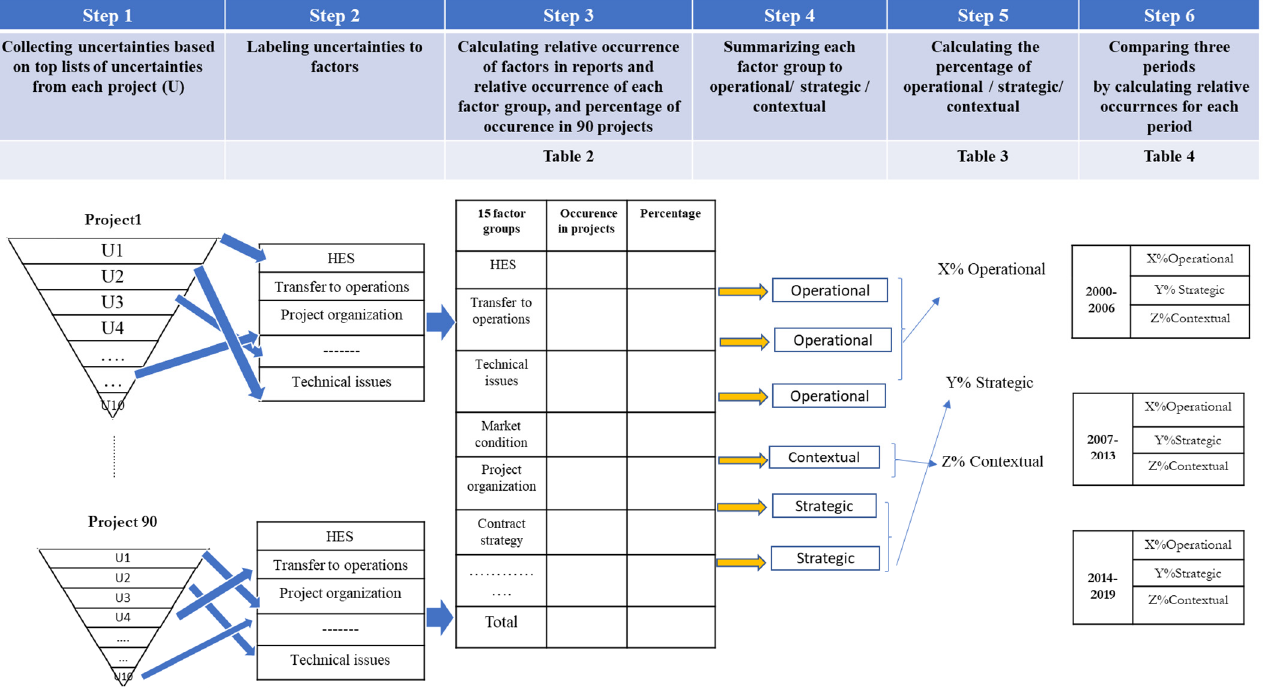
Figure 1. Six steps for the analysis of data from 90 road projects.